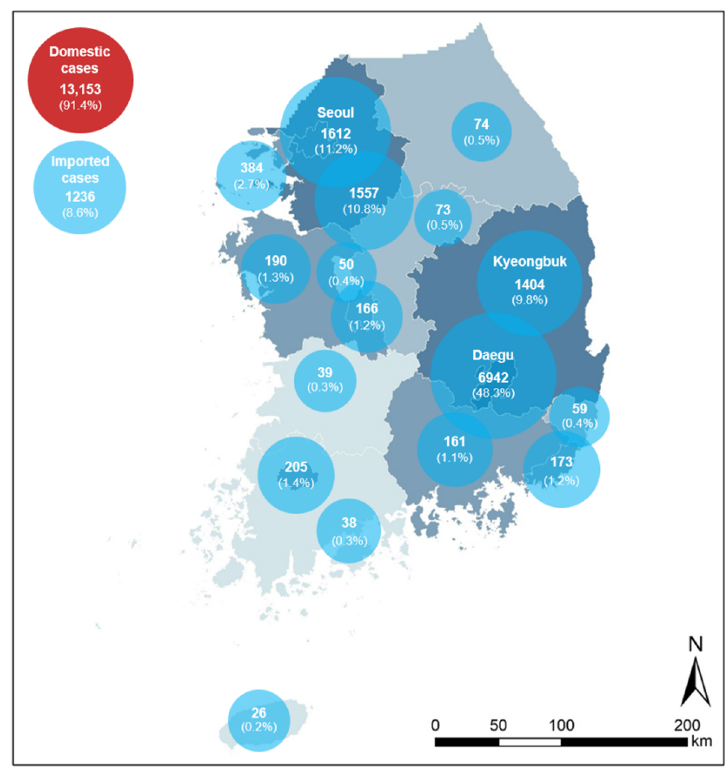
Figure 1. Map of the study areas and confirmed COVID-19 cases as of 3 August 2020.